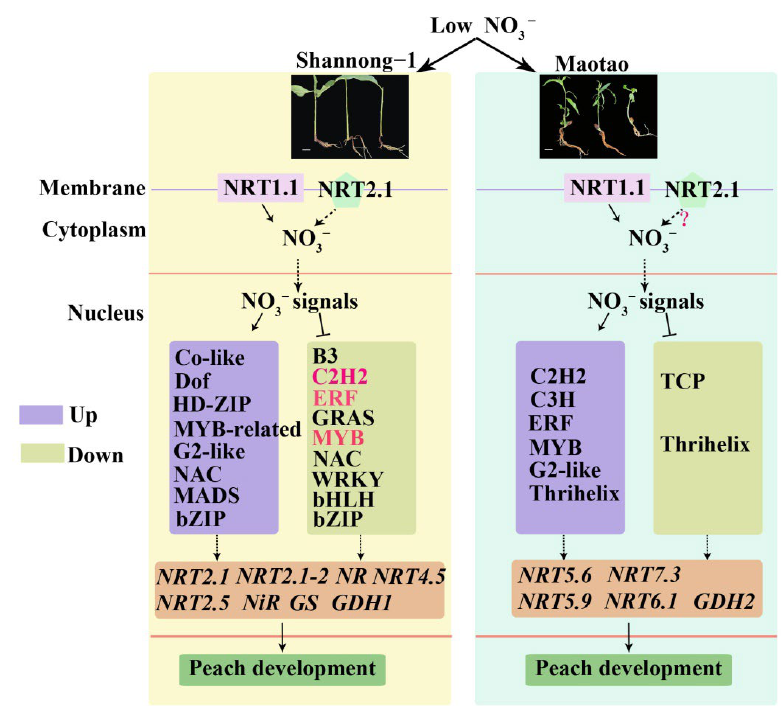
Figure 10. Model diagram of effects of low NO 3 − on Shannong–1 and Maotao. Low concentrations of NO 3 − activated (Up) and inhibited (Down) the transcription of different transcription factors in Shannong–1 and Maotao, which have different effects on downstream genes, making the two rootstocks exhibit different nitrogen utilization capabilities.